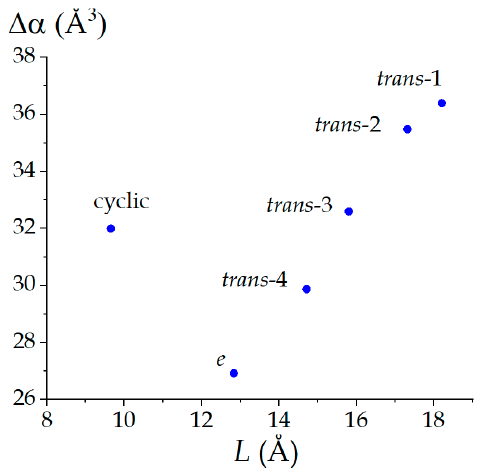
Figure 2. Dependence of the polarizability exaltation on the distance between the marginal fullerene cores in (C 60 ) 3 . The data associated with the plot could be found in Table 1.